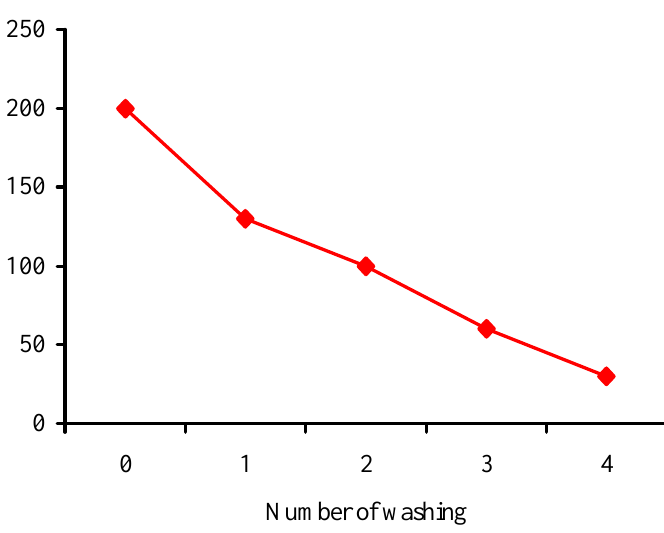
FIGURE 4 . Effect of washing on Na removal from